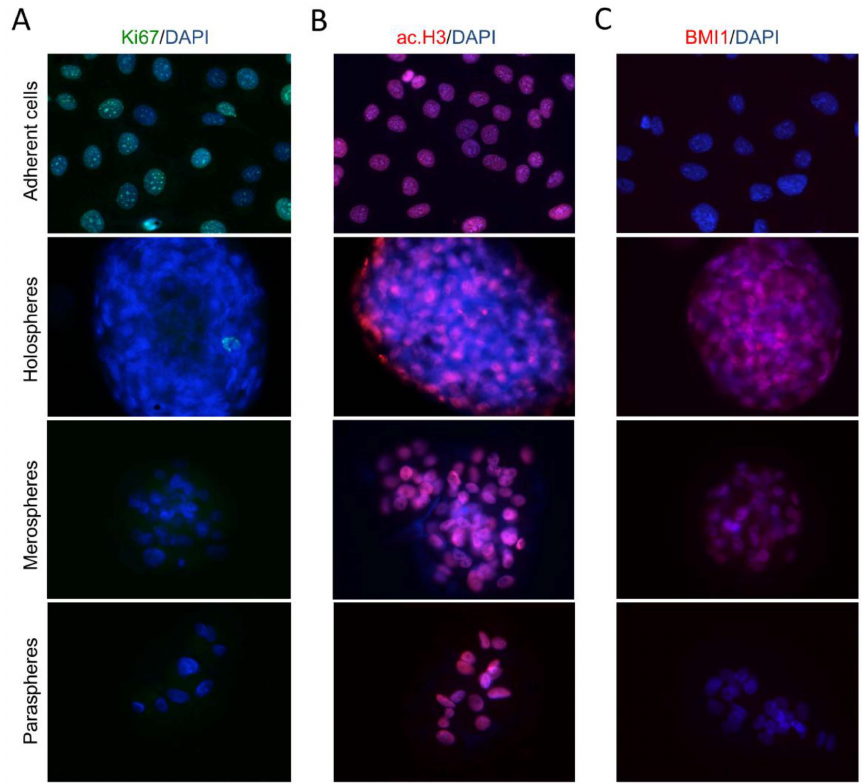
Figure 6. Tumor spheres present reduced proliferation and express stem cell hallmarks. ( A ) Proliferation of tumor spheres is reduced compared to tumor cells growing in adherent conditions (magnification ˆ 200); ( B ) Histone acetylation of tumor spheres. Holospheres have reduced histone acetylation compared to merospheres, paraspheres and tumor cells growing in adherent conditions (magnification ˆ 200); ( C ) Unlike paraclones and tumor cells growing in adhesion, holospheres and merospheres express BMI-1 (magnification ˆ